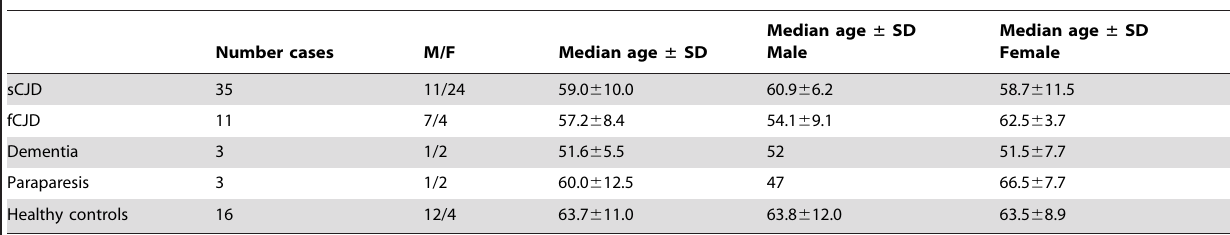
Table 1. General information for CSF